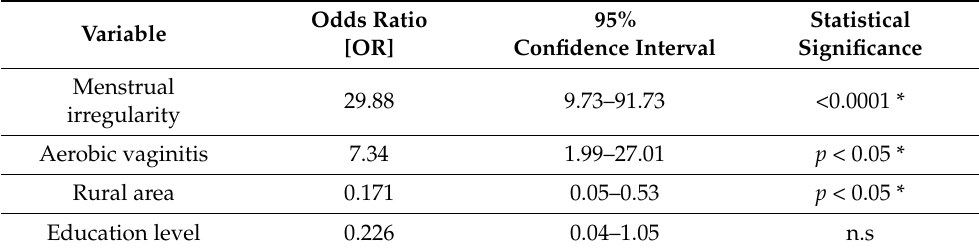
Table 3. Multivariable regression analysis of RPL with significant factors.